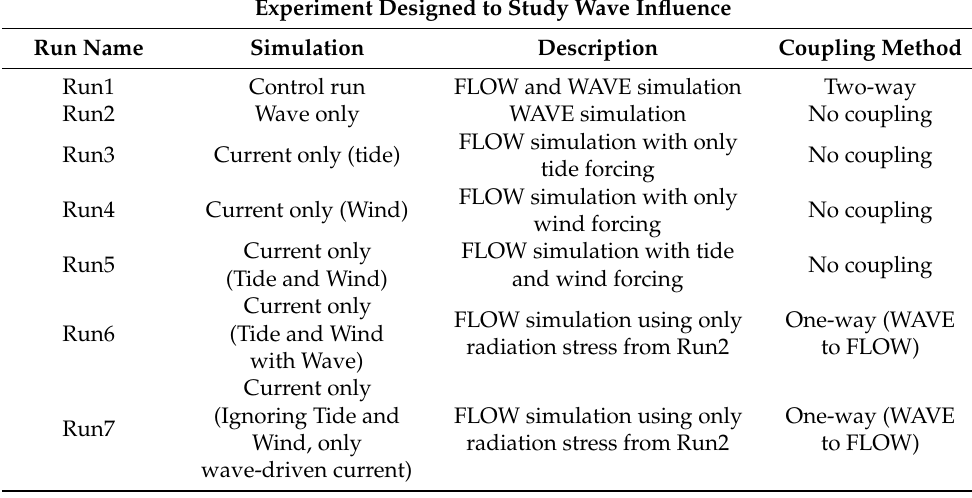
Table 2. Scenario details to investigate the influence of wave–current interaction in cyclone-induced storm surge height. Experiment Designed to Study Wave